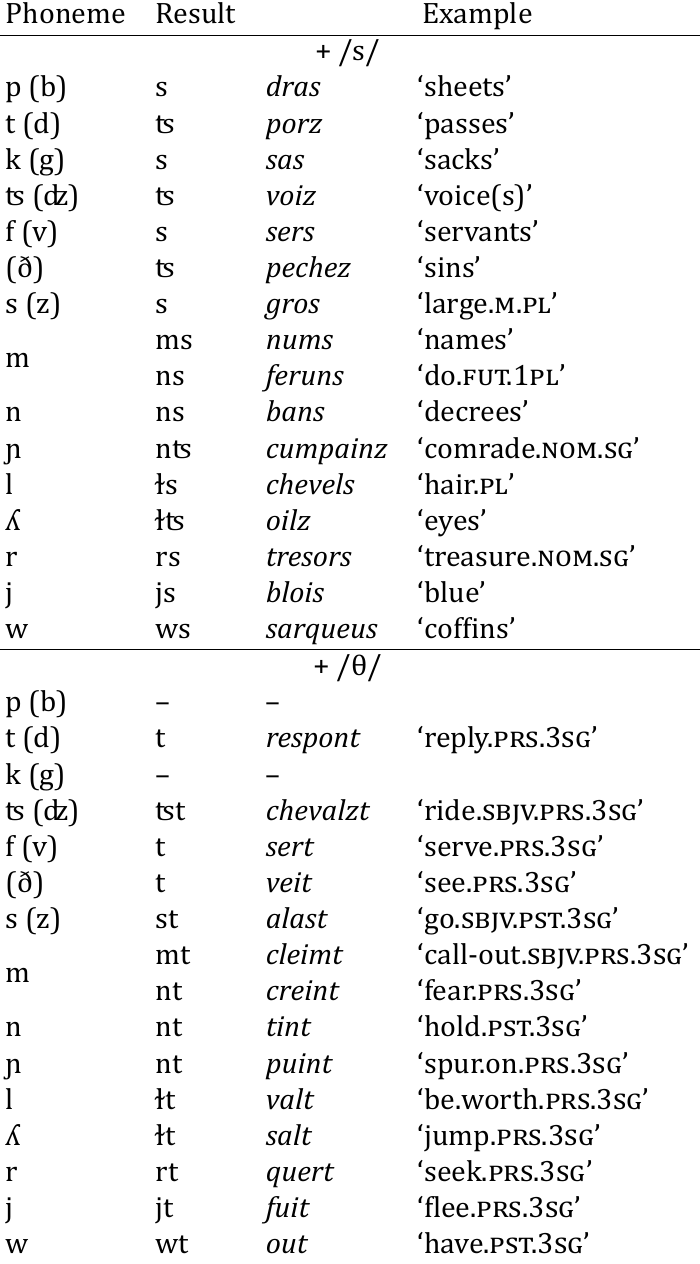
Table 4: Flexional consonants /s/ and /θ/ with Type C word-(cid:976)inal